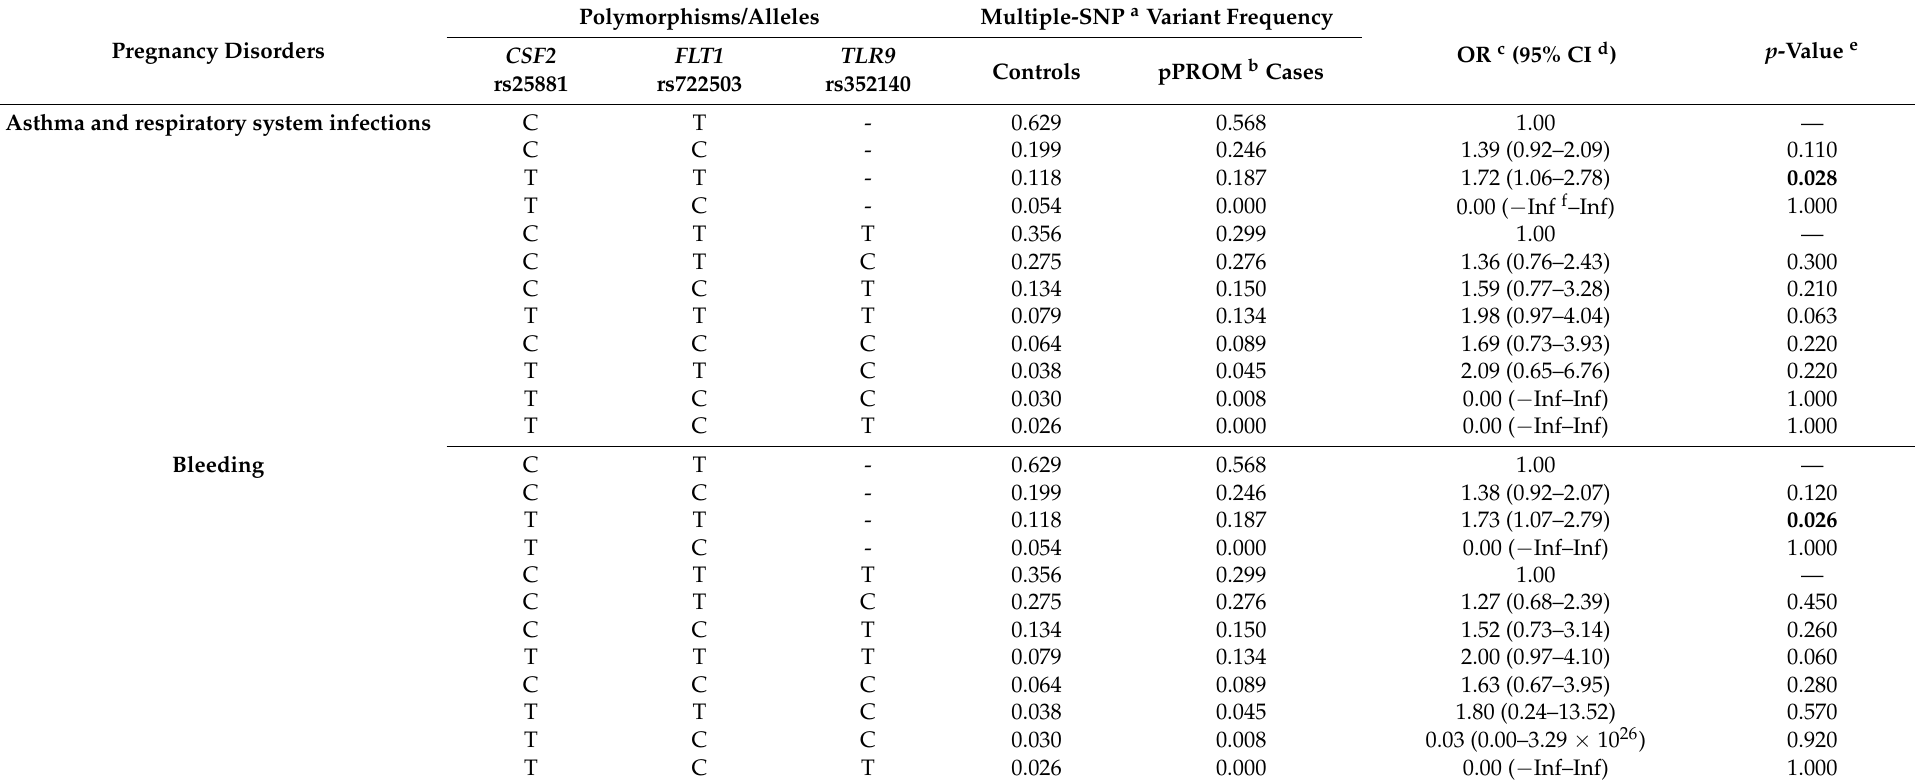
Table 4. Relationship between multiple-SNP variants for CSF2 , FLT1 and TLR9 polymorphisms and occurrence of preterm PROM after correction for pregnancy disorders.